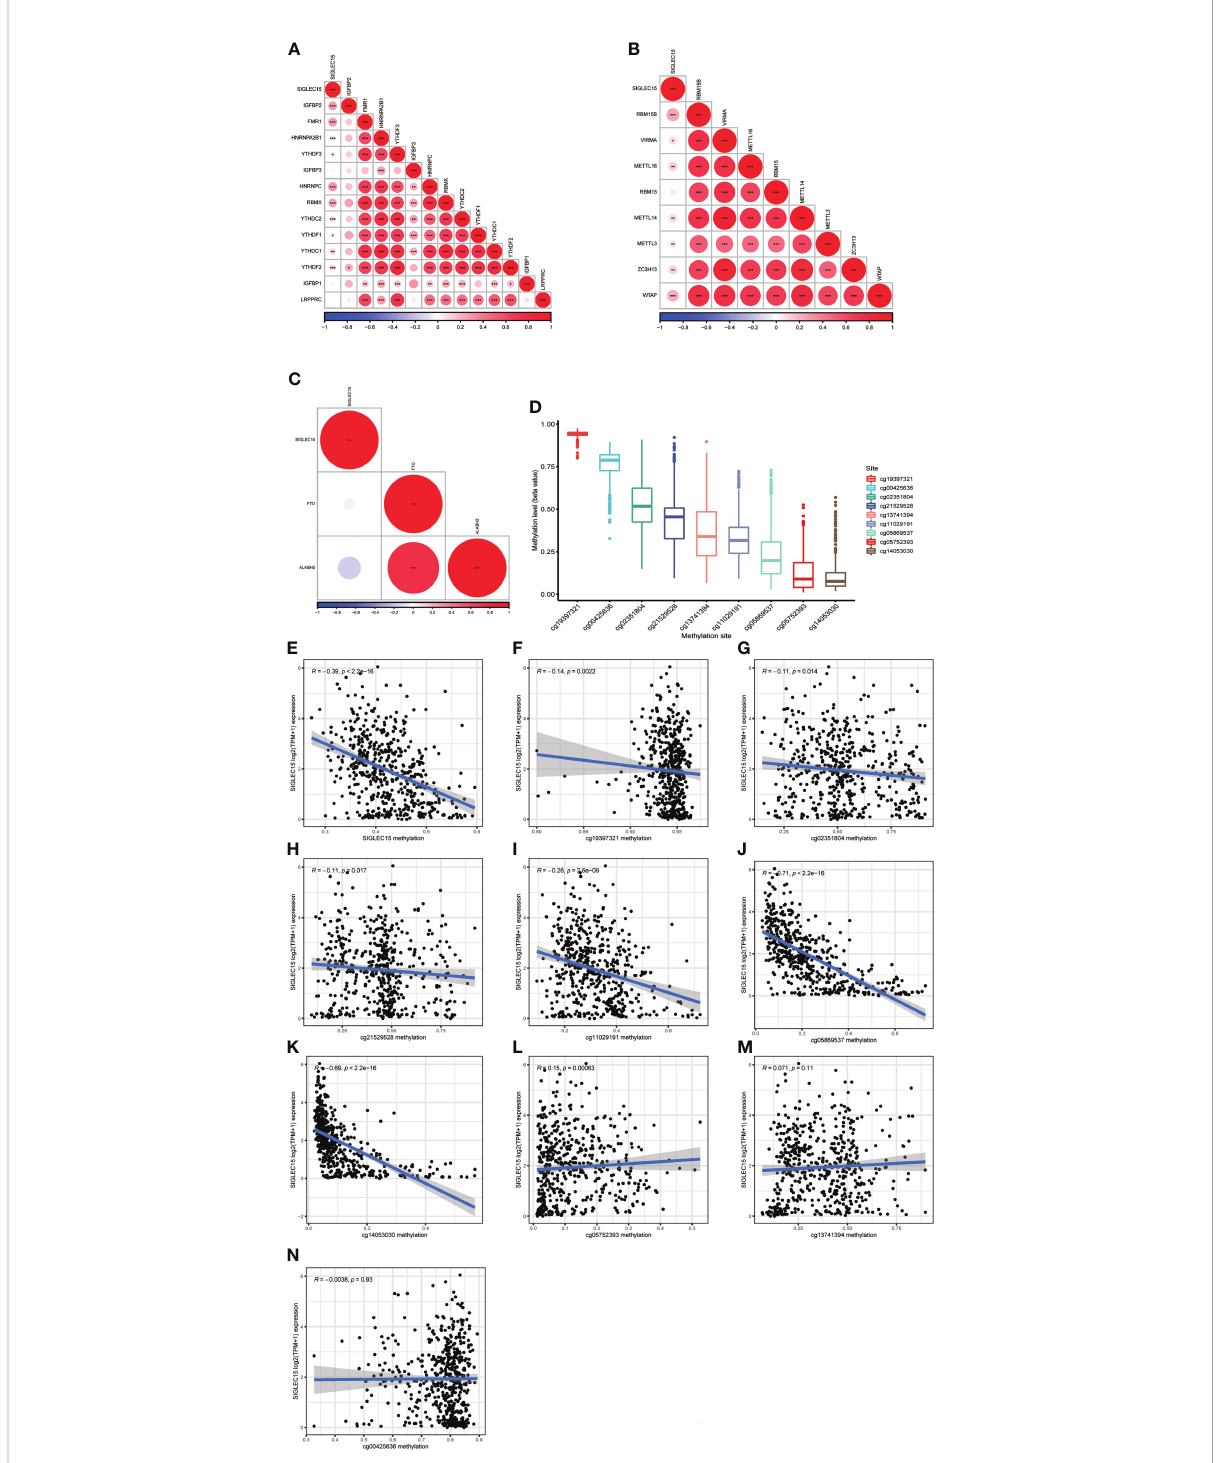
FIGURE 6 SIGLEC15 mRNA expression correlation with DNA methylation and m6A regulator mRNA expression. (A – C) SIGLEC15 mRNA expression correlation with (A) m6A readers, (B) writers, and (C) erasers. (D) Each CpG methylation site level of SIGLEC15 . (E) SIGLEC15 mRNA expression correlation with averaged CpG methylation site. (F – N) SIGLEC15 mRNA expression correlation with DNA methylation of each CpG methylation